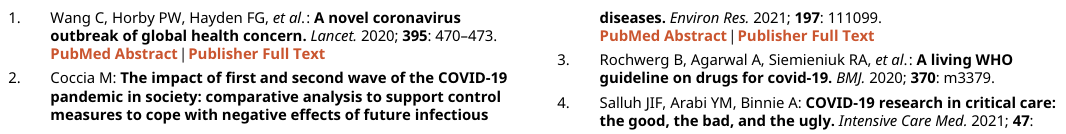
Figshare: PRISMA checklist for ‘ the association between therapeutic plasma exchange and the risk of mortality among patients with critically ill COVID-19: a meta-analysis. https://doi.org/10.6084/m9.figshare.16622572.v1 16 Data are available under the terms of the Creative Commons Attribution 4.0 International license (CC-BY